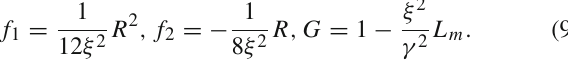
Fig. 4 The redshift evolution of the dust density abundance (cid:18) m ( z ) and of the Weyl vector A 0 ( z ) for the conformally invariant quadratic Weyl cosmological model (91), for lower 2 σ limit (dashed), best fit